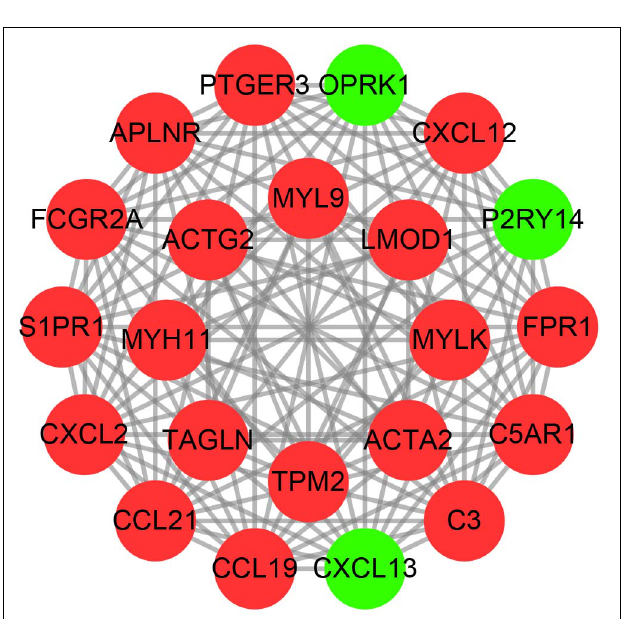
FIGURE 4 | The hub PPI networks of the DEGs. Each circle represents the genes, while the lines denote the interaction among proteins from different genes. Red and green dots indicate relatively upregulated and downregulated genes,